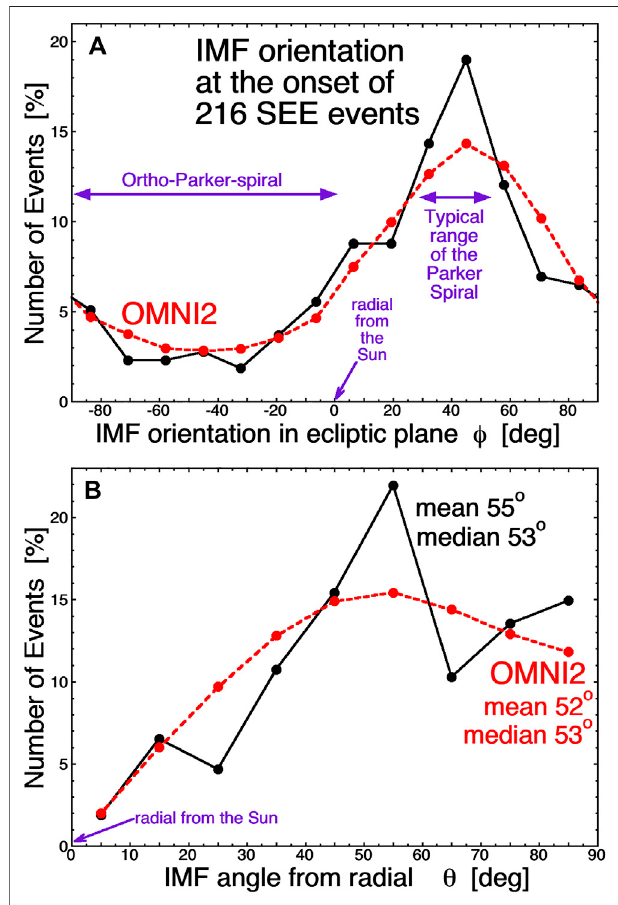
FIGURE 3 | The orientation of the solar-wind magnetic fi eld at the onset of 216 strong solar-energetic-electron events is binned (black solid) and compared with 380,458 hourly values of the solar-wind magnetic fi eld from the OMNI21963-2020 data set (red dashed). (A) isthe orientation of the projectionofthemagnetic fi eldintotheeclipticplaneand (B) istheangleofthe fi eld line from the Moon-Sun